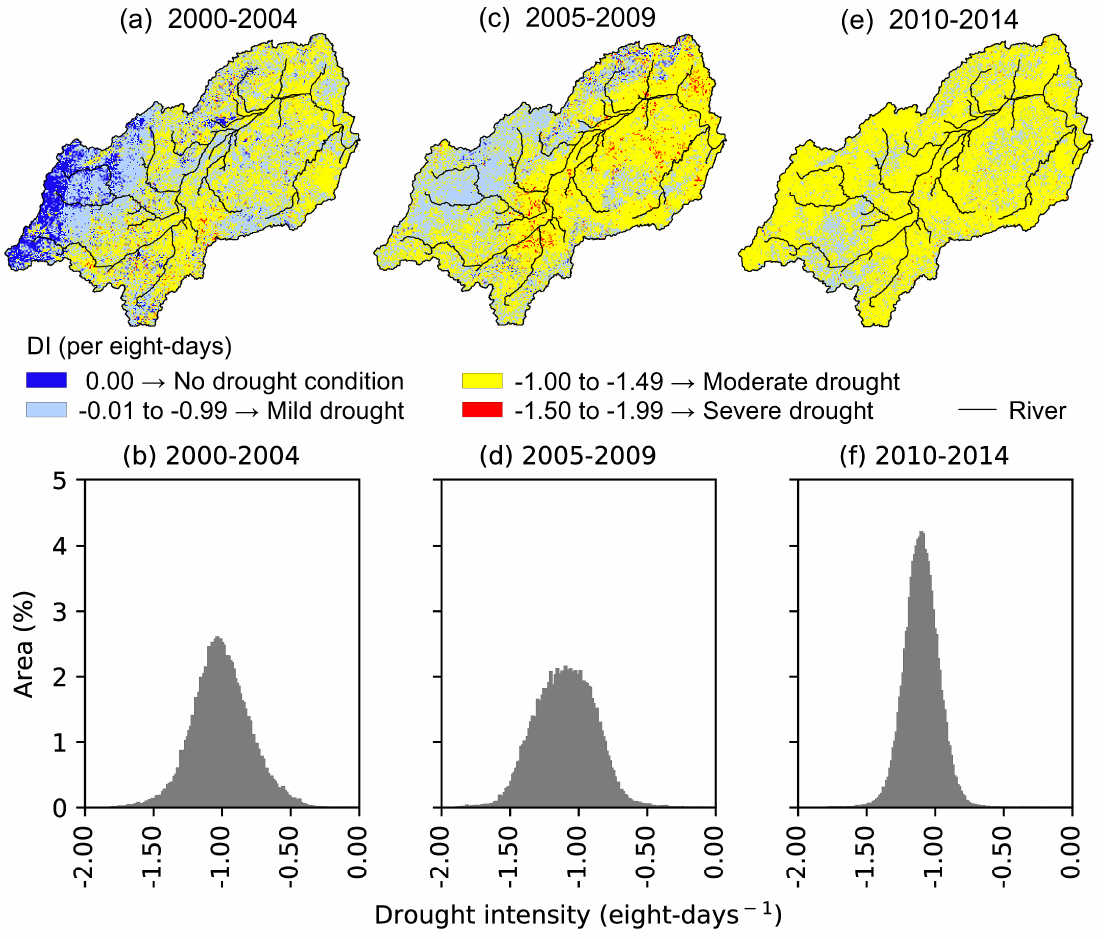
Figure 8. Map ( a ) and histogram ( b ) of drought intensity (DI) during the first quinquennium. Map ( c ) and histogram ( d ) of DI during the second quinquennium. Map ( e ) and histogram ( f ) of DI during the third quinquennium.